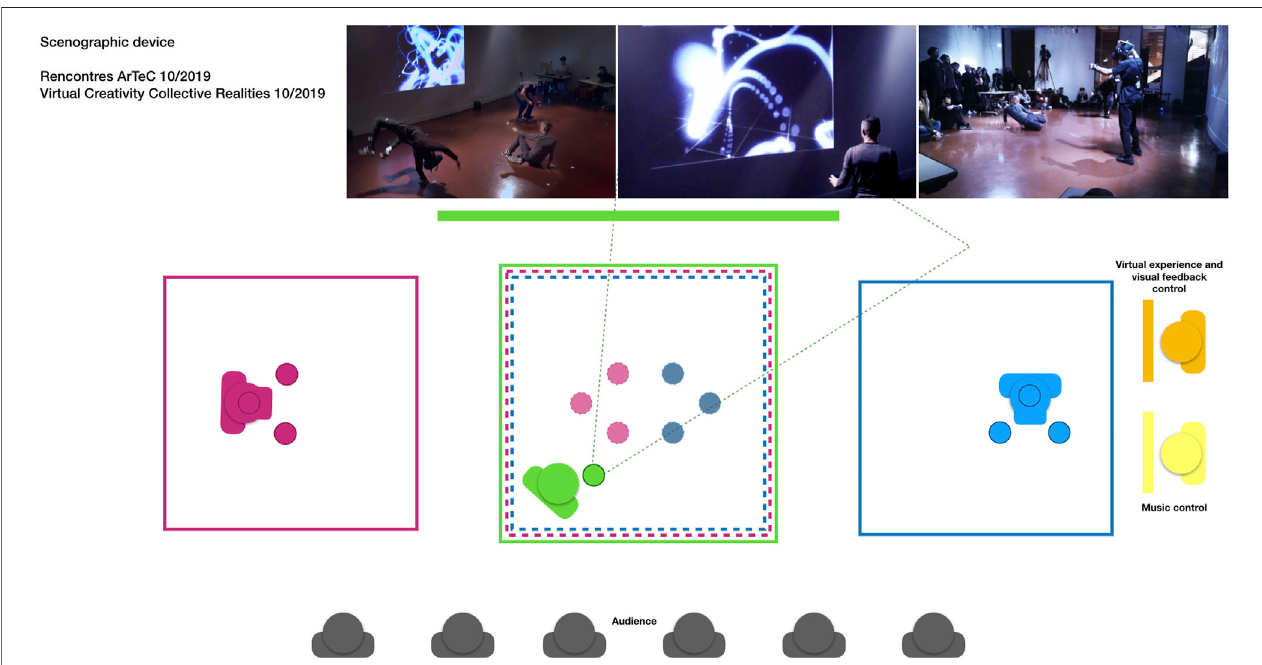
FIGURE13| Research-creationinstallationThered andbluezones aretheactionspaces ofthetwodancers, whereasthegreenzoneistheMixedrealityspacethe mediator ’ s action space superimposed on the virtual space merging the presence of the dancers.